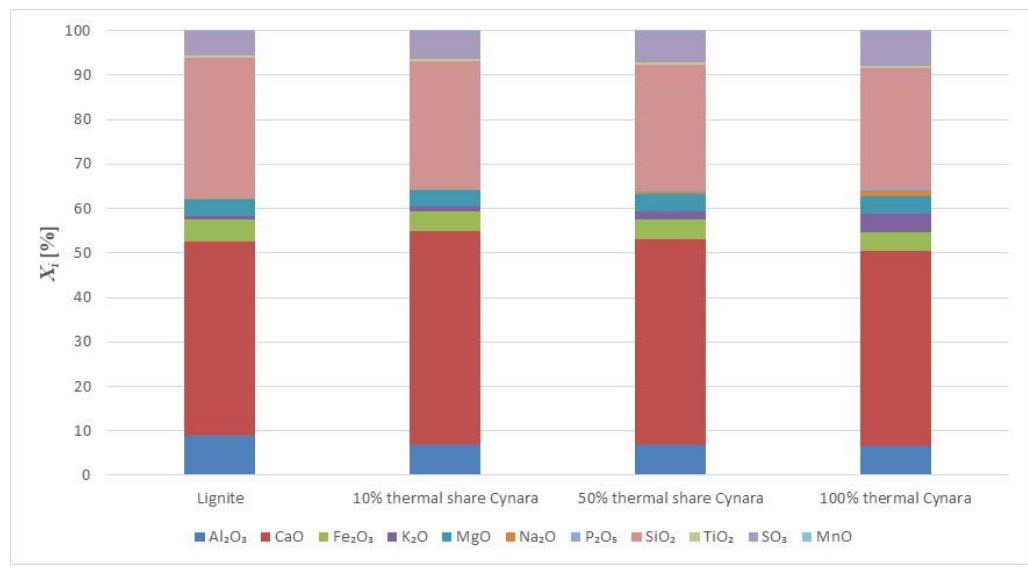
Figure 6. Major and minor oxides of fly ashes, I.